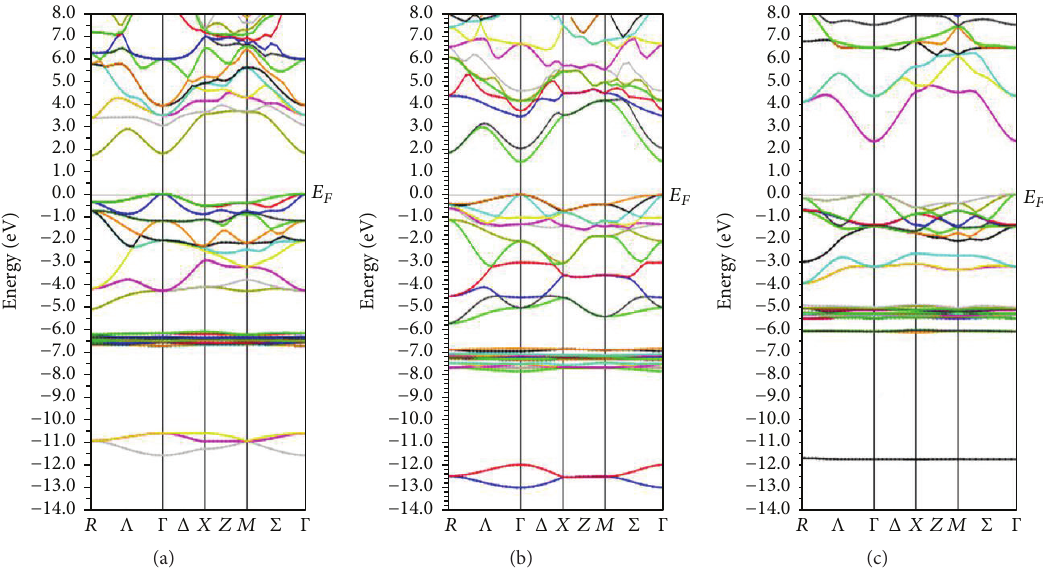
Figure 2: Bandgap energies of (a) ZnO 0.25 Te 0.75 , (b) ZnO 0.50 Te 0.50 , and (c) ZnO 0.75 Te 0.25 .